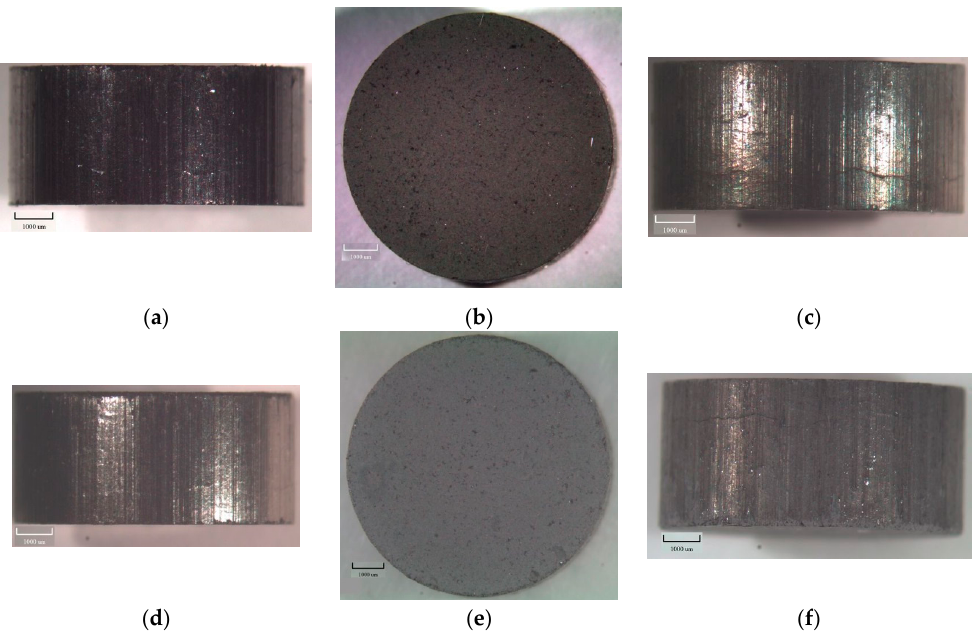
Figure 2. Pellets of MgH 2 –5Fe–5ENG before ( a ) and after ( b , c ) 20 cycles; pellets before ( d ) and after ( e , f ) 45 cycles.